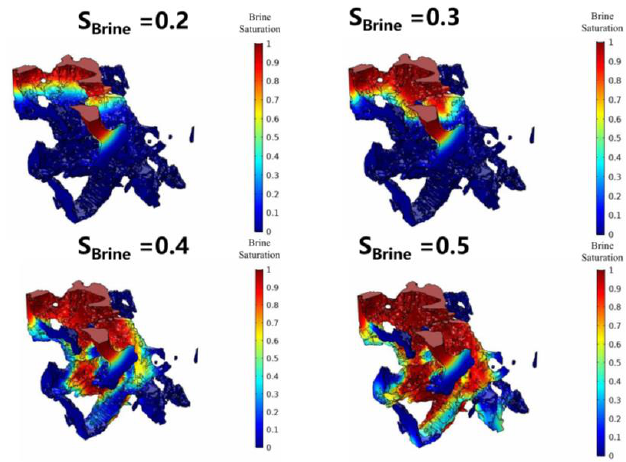
Figure 15. Steady-state brine distribution of the tighter REV, during the CO 2 –brine imbibition process over a range of target saturation from 0.2 to 0.5., the flow pattern and fluid distribution are stabilized when the global target saturation reaches 0.5 where the flow is channelized and dominated by brine.